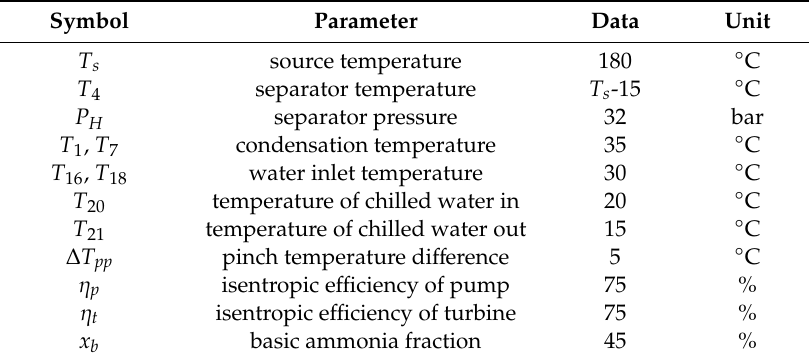
Table 1. Basic conditions for simulation.